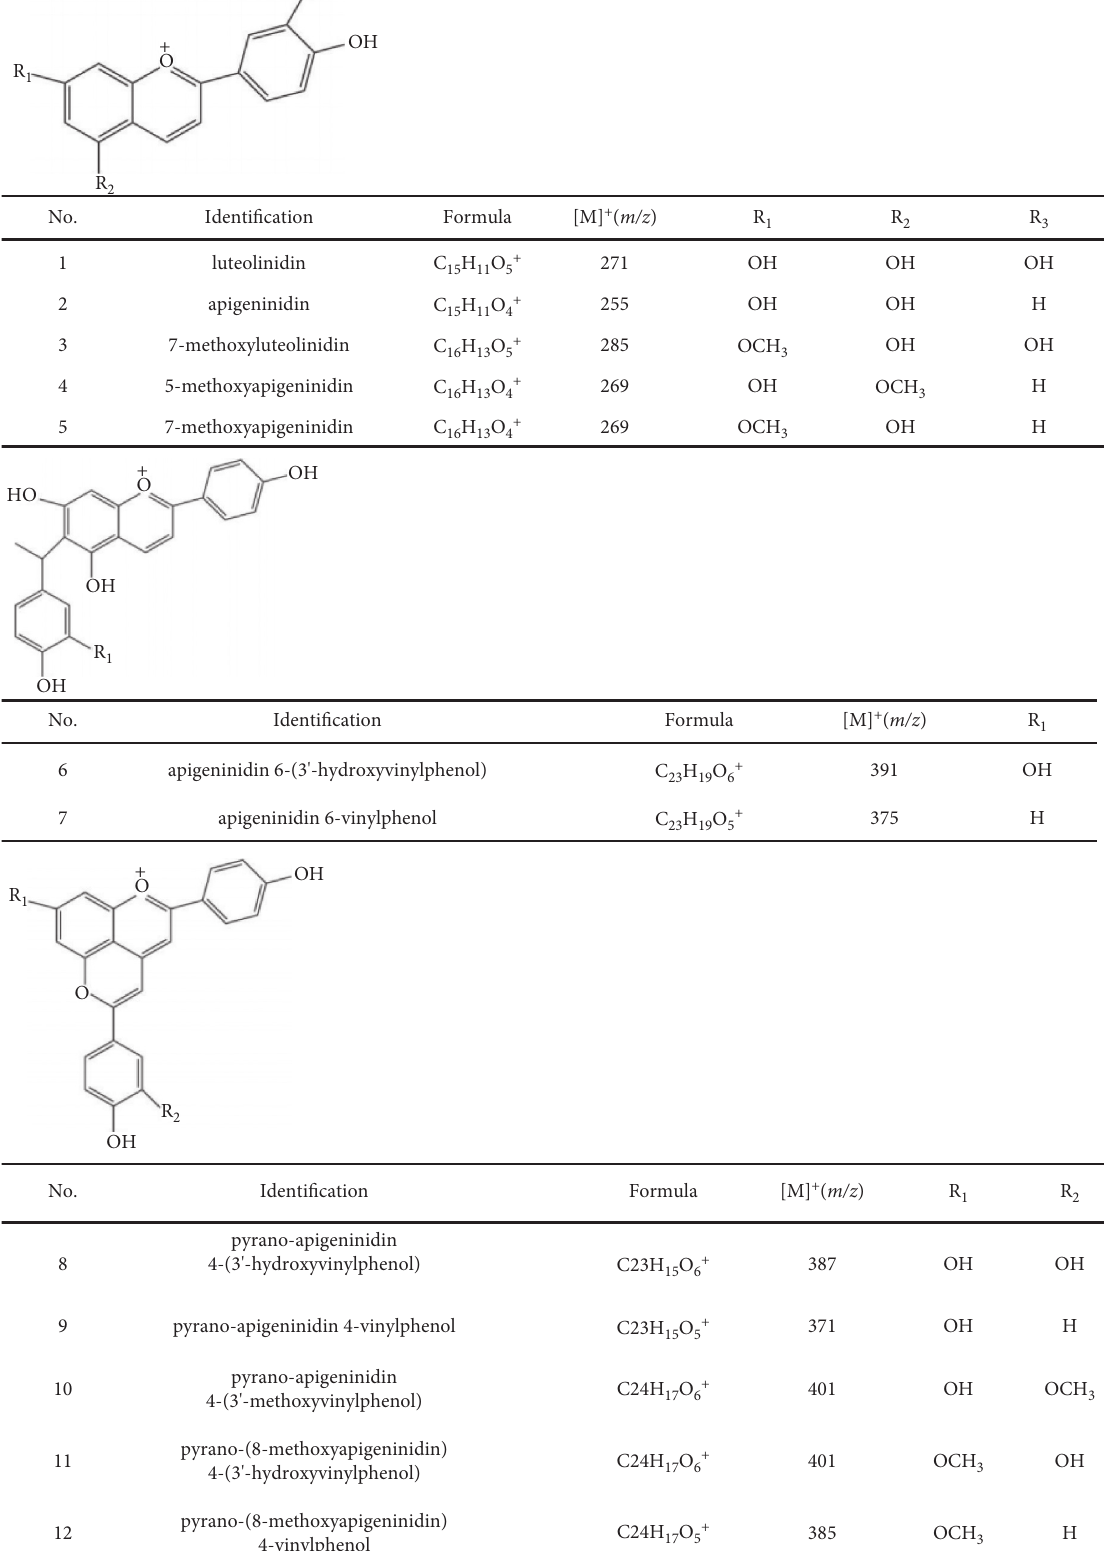
Figure 1: Chemical structures of 3-deoxyanthocyanidins, vinylphenol and pyrano adducts of fermented deoxyanthocyanidins. Modified from Literature 17 and